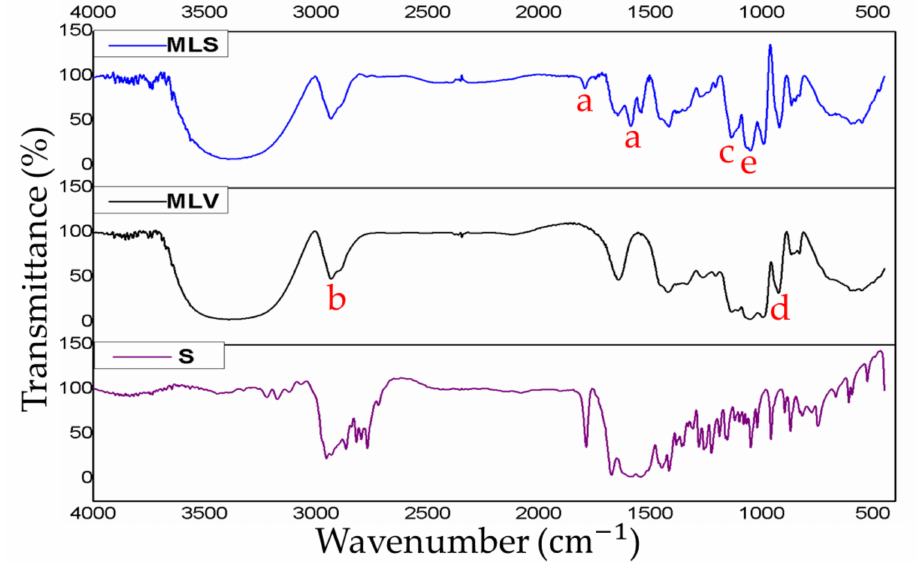
Figure 3. Infrared absorption spectrum of nanostructured and free drug systems analyzed by infrared (IR) vibrational spectroscopy. Upper-case letters represent compounds and nanostructures under insvestigation: S: N, N’ -Squaramide 17, MLV: Empty mimetic lipid membranes, and MLS: Mimetic lipid membranes containing N, N’-Squaramide 17. Lower-case letters represent IR absorption peaks: a - 1800 cm − 1 and 1591 cm − 1 of C = O; b - 3392 cm − 1 of R–NH 3 ; c - 1052 c − 1 of NH 3 + ; d - 995 cm − 1 of PO 2 − ; e - 1136 cm − 1 of POO 2 −